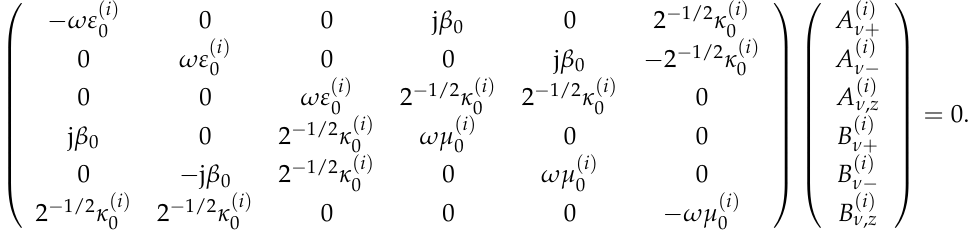
Table 3. Effect of diamagnetic substitution, x , in yttrium iron garnet Y 3 Fe 5 in effective guide indices in a waveguide with nonmagnetic cladding, ∆ N co , on the difference in effective guide indices in the waveguide with magnetic cladding, ∆ N , and on the distance, d , required for the phase shift π /4. x 0.2 0.4 0.6 0.8 1.0 1.2 ∆ N co × 10